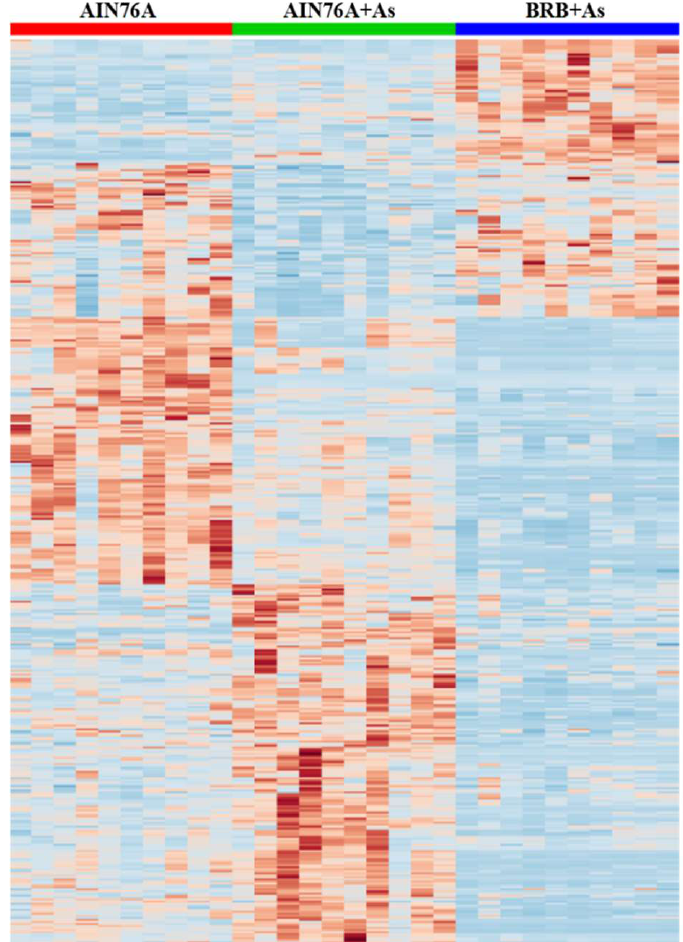
Figure 4. Hierarchical clustering heat map constructed using intensities of shared metabolite features (76, 76+ As, and BRB+ As groups) to display the pattern of modulation of BRBs on As-induced alterations in microbial metabolite fingerprints.